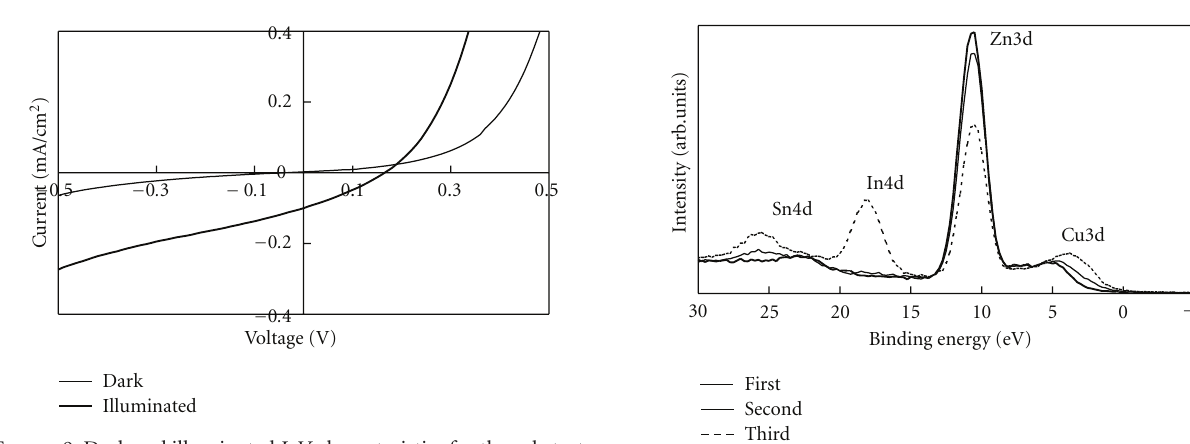
Figure 9: Dark and illuminated I - V characteristics for the substrate heterojunction with the 5-min-deposited CTSO film (condition 1).